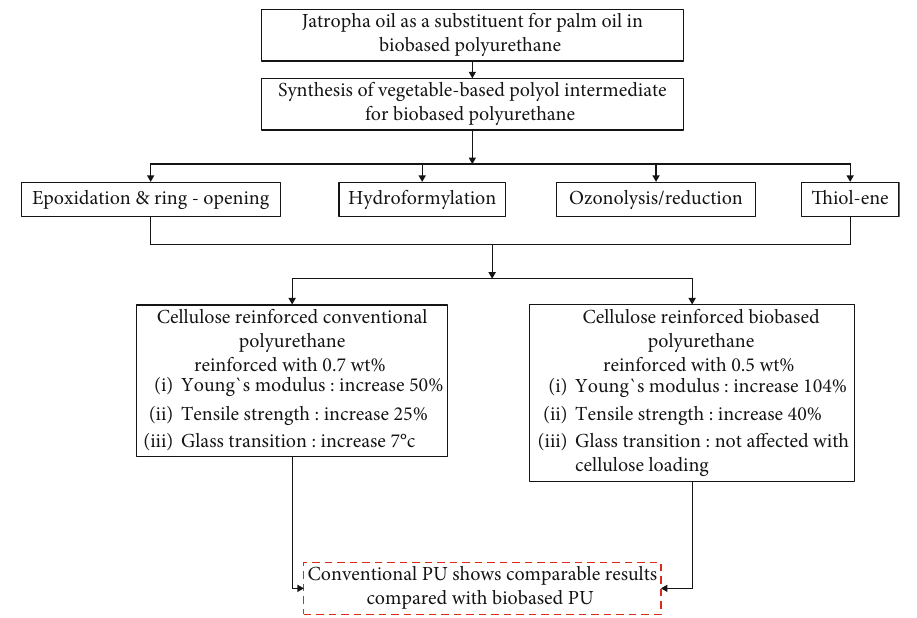
Figure 2: Chemical structure of commonly used isocyanates [24]. Table 1: Chemical composition comparison of fatty acid pro fi le.